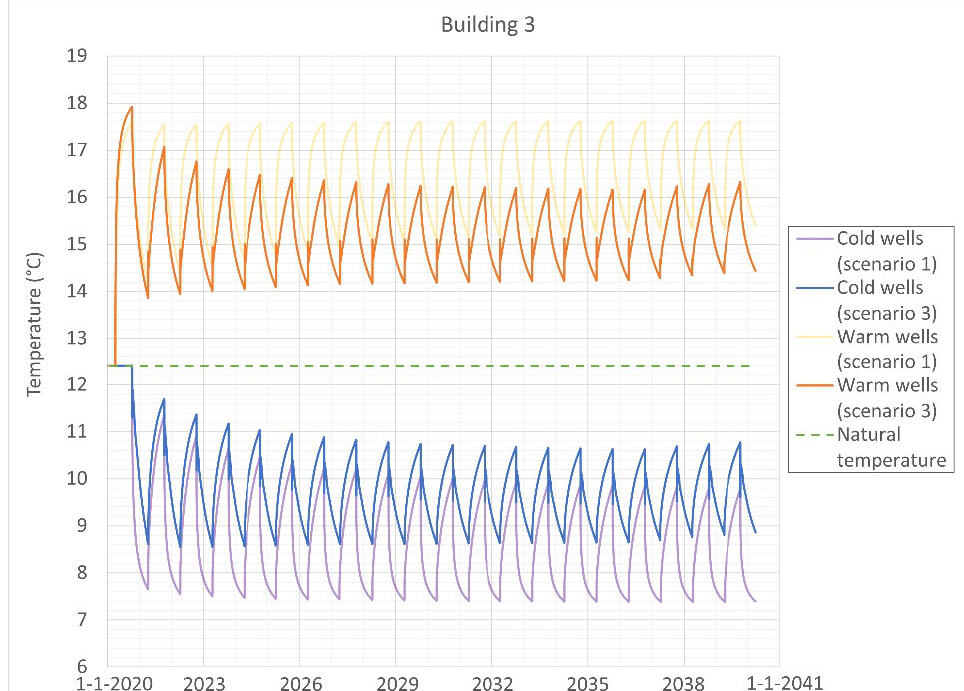
Figure 11. Simulated long-term evolution of the mean temperature at the hot and cold wells (in the deep aquifer) for Building 3 for the second scenario involving a cooling power of 427 kW and a heating power of 286 kW, compared with the first scenario.